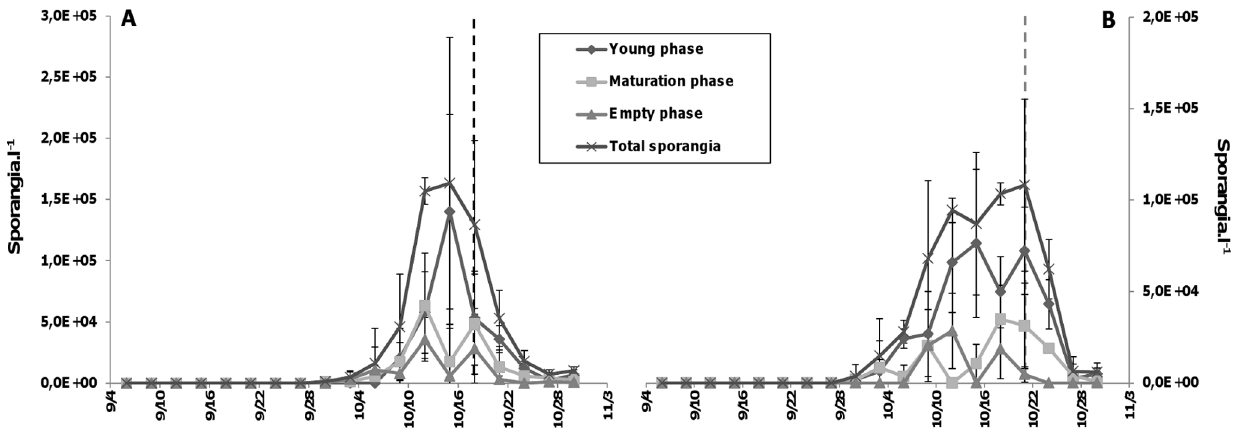
Figure 4. Dynamics of the different phases of life cycle of Rhizosiphoncrassum . Dynamics of the three different phases of the life cycle of the chytrid Rhizosiphon crassum infecting the cyanobacterium Anabaena macrospora at 0.5 m (A) and in the depth of maximum chlorophyll (MF) (B) in Lake Aydat, September 6 th to October 30 th 2010. The three phases regroup the six stages of life as above: Young phase (Stages 1 and 2), Maturation phase (Stages 3, 4 and 5) and Empty phase (Stage 6) (see the main text for details). Vertical lines mark the transition point between the increasing and the decreasing phases in the prevalence of infection of filaments (PrF), at 0.5 (dark dashed line) and MF (grey dashed line) depths.